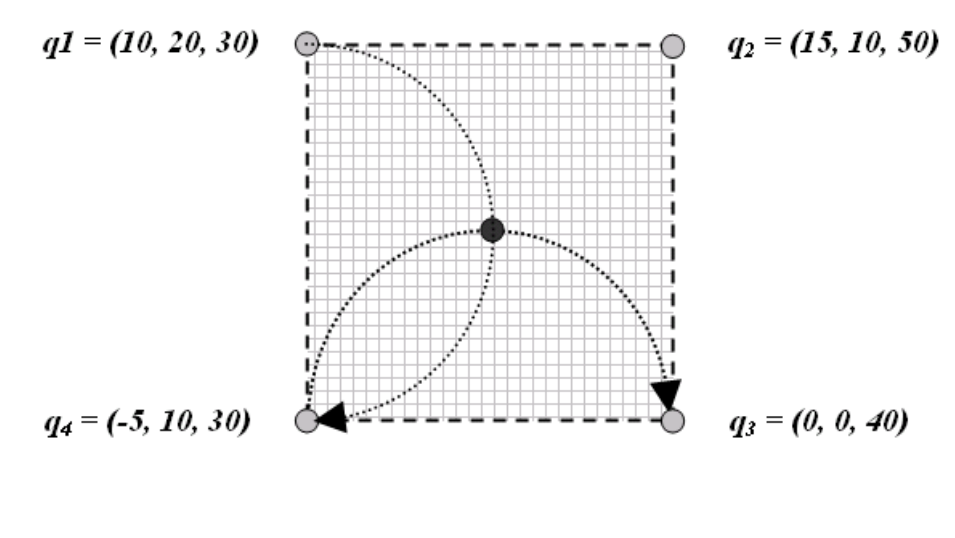
{ i [1–4]} values ( φ , κ , ω ) i